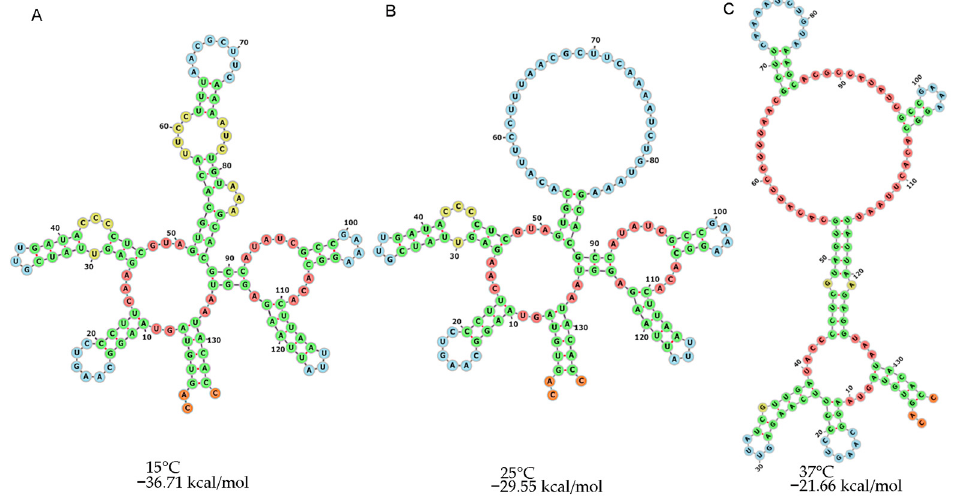
Figure 4. Secondary structure prediction of cspA 5 (cid:48) UTR of pCOLDl II under varying tempera- ture conditions. The models were obtained using RNAfold (http://rna.tbi.univie.ac.at/cgi-bin/ RNAWebSuite/RNAfold.cgi, accessed on 18 August 2022) and showed predictions with the following temperature parameters: ( A ) 15 ◦ C; ( B ) 25 ◦ C; and ( C ) 37 ◦